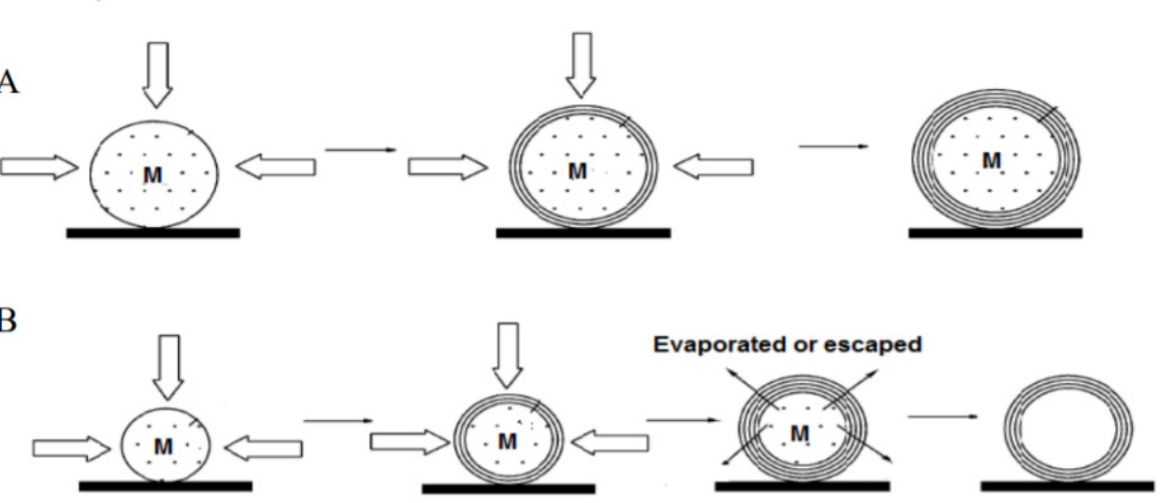
Figure 21. Schematic diagram of the growth mechanism of CNOs. ( A ) CNOs contain metal particle core. ( B ) CNOs with an empty core [92].